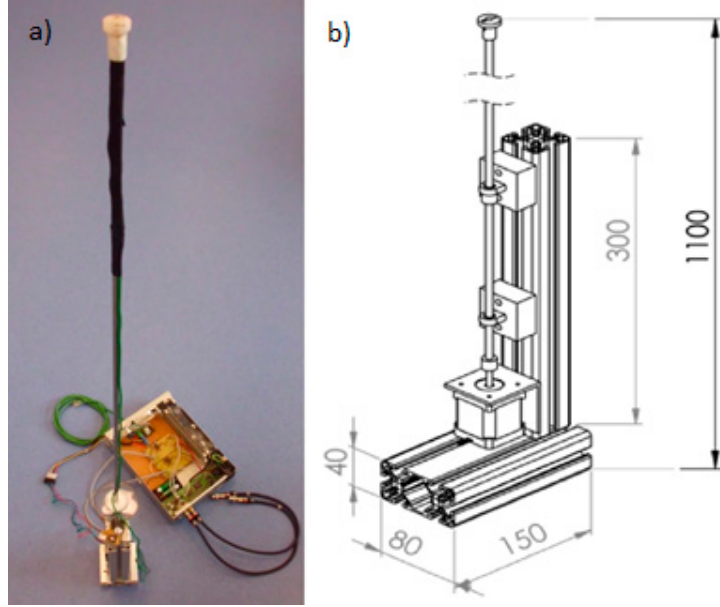
Figure 1. Construction of the 2D sound intensity probe based on two microphones (dimensional units are millimeters); ( a ) photo of real probe; ( b ) construction details.